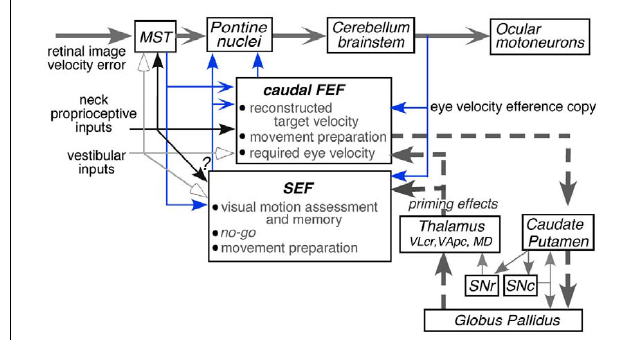
FIGURE 15 | Proposed signal flow diagram for smooth-pursuit eye movements and major signals in the SEF and caudal FEF. Gray thick arrows indicate the direct pathways.Thin arrows indicate indirect pathways through the SEF and caudal FEF.Thick gray dashed lines indicate the pursuit loop between the caudal FEF and basal ganglia through the thalamus proposed by Cui et al. (2003). ? Indicates whether SEF pursuit neurons receive neck proprioceptive inputs remains undetermined. MD, medial dorsal nucleus; SNc, substantia nigra pars compacta; SNr, substantia nigra, pars reticularis;VApc, ventral anterior nucleus, pars parvocellularis;VLcr, rostral portion of the ventral lateral nucleus, pas caudalis. See text for further